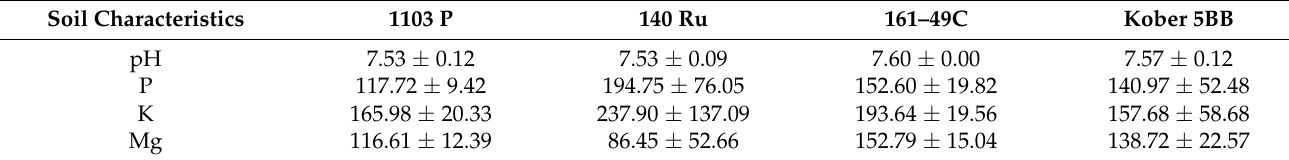
Table 1. Main chemical characteristics of the soil of the four different rootstocks. Phosphorus (P), potassium (K) and magnesium (Mg) values are expressed in mg kg − 1